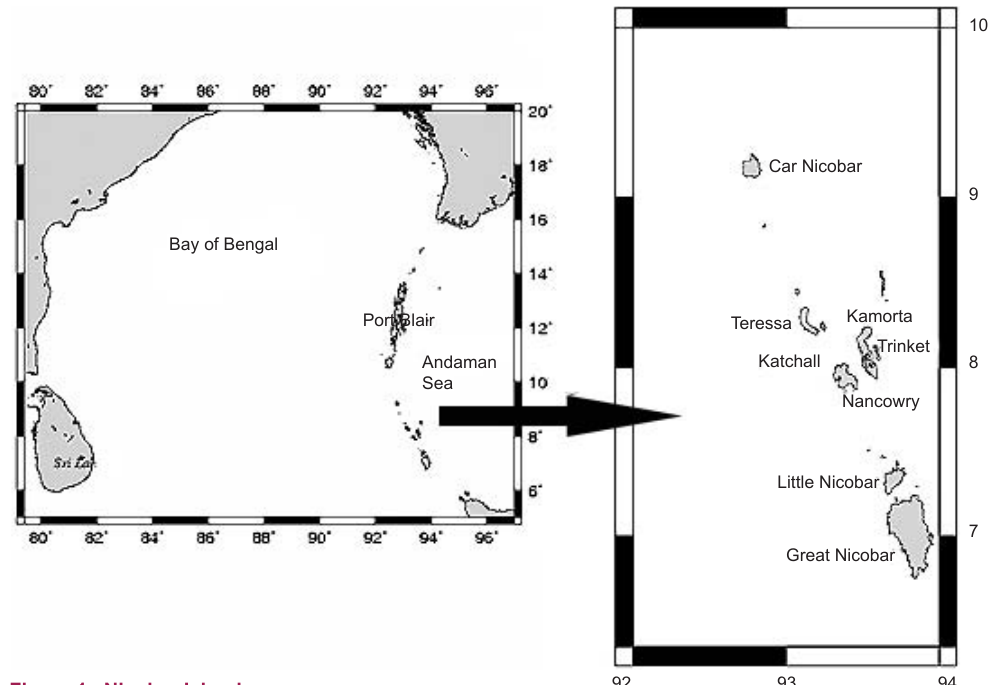
Figure 1. Nicobar Islands.